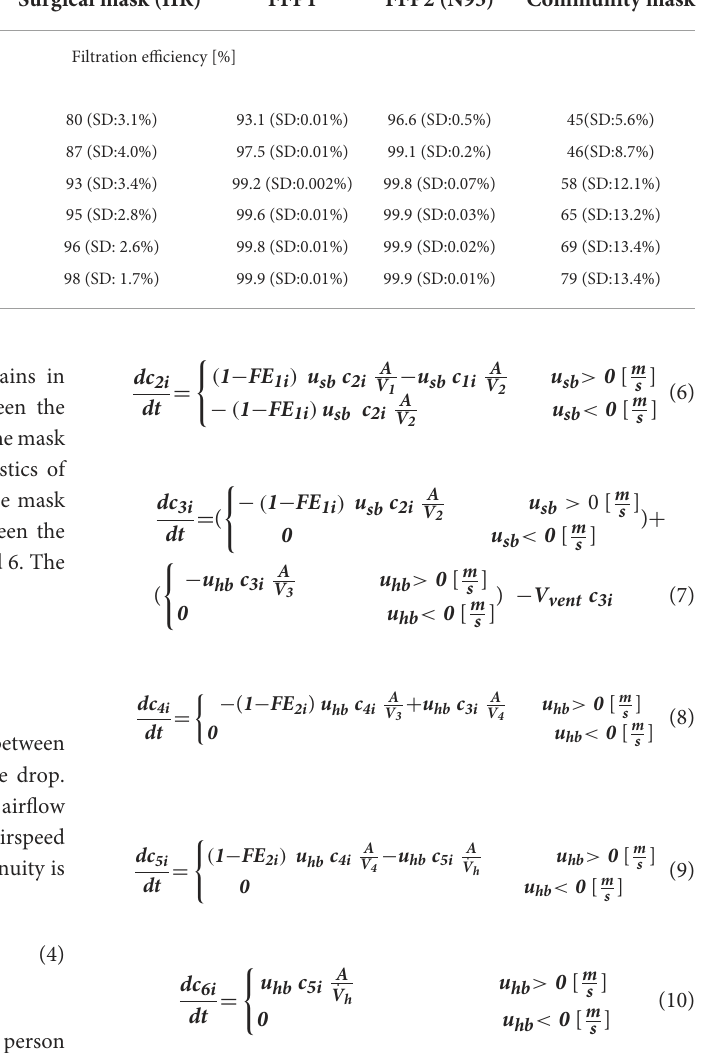
Where c i is the number of aerosols in medium i (shown in Figure 3), u sb and u hb are the air velocity of breathing for the infected person and healthy person, respectively. The surface area is shown by A, and V i is the volume of medium i. In these equations, FE 1i refers to the filtration efficiency of the infected person’s mask, and FE 2i refers to the filtration efficiency of the healthy person’s mask.